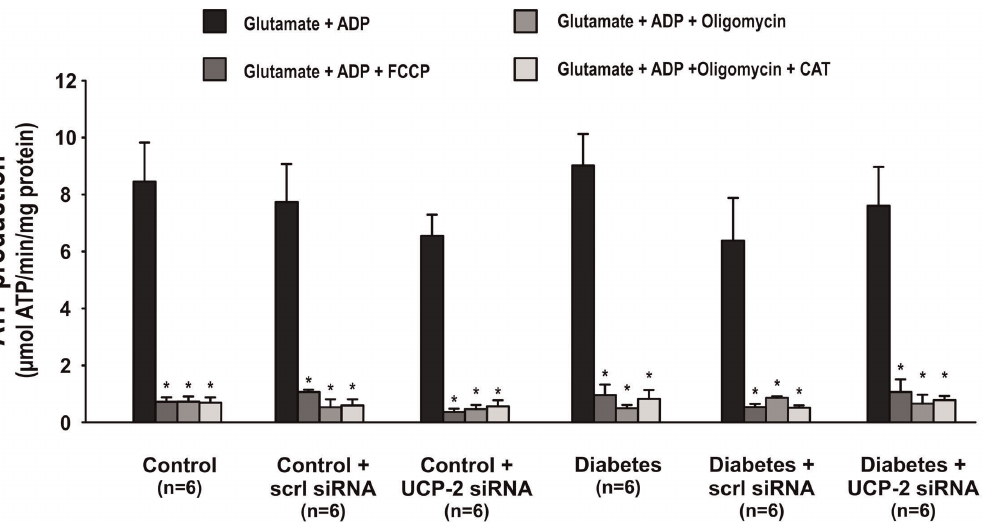
Figure 7. Mitochondria ATP-production during no incubation and after oligomycin, FCCP or CAT in control and diabetic animals without scrambled or UCP-2 siRNA. * denotes p , 0.05 vs. no incubation within the group.